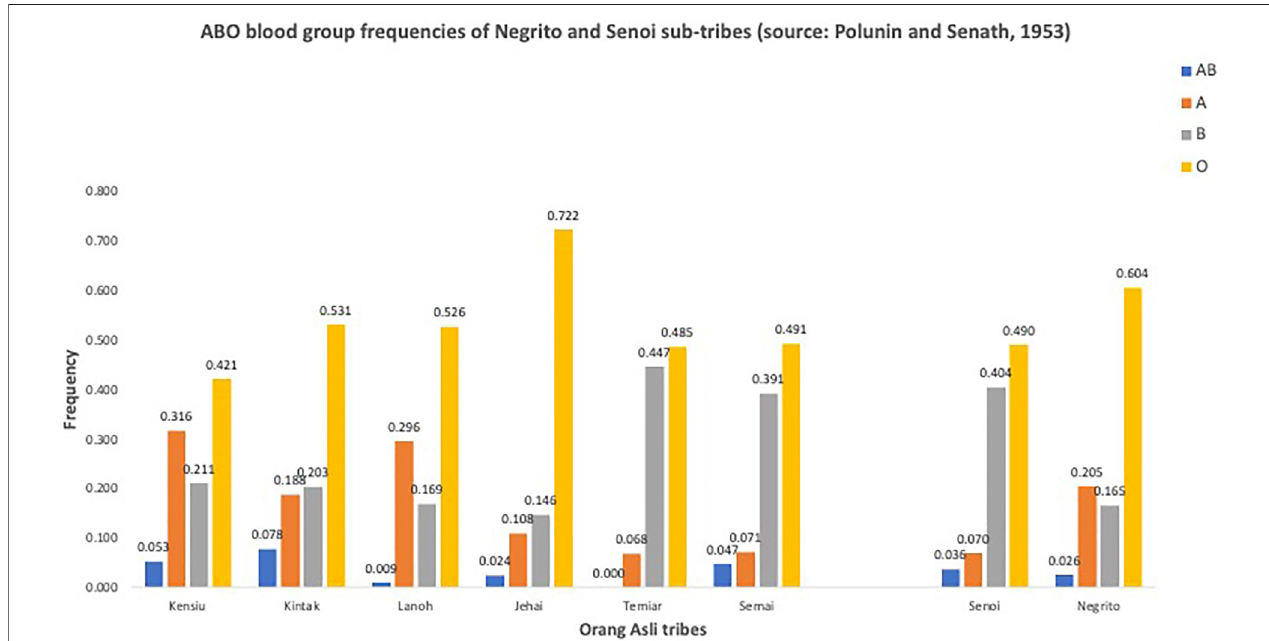
FIGURE 2 | ABO blood group frequencies of Negrito and Senoi sub-tribes (adapted from: Polunin and Sneath, 1953).